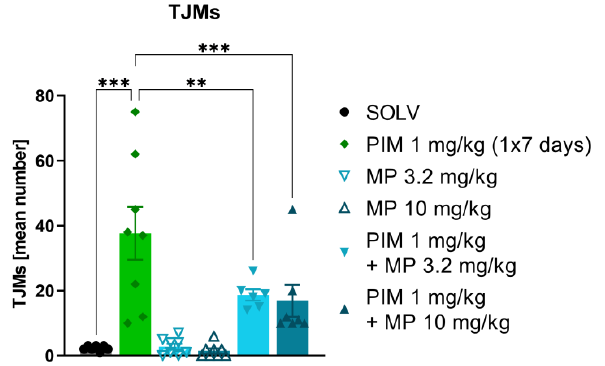
Figure 3. Reversal of the pimozide-induced tremulous jaw movements (TJMs) by MP-III-024 (3.2, 10 mg/kg). The data are shown as the mean (± SEM) number of tremulous jaw movements (TJMs) per 10 min observation period. The number of animals: SOLV, n = 7; PIM 1 mg/kg, n = 8; MP 3.2 mg/kg, n = 8; MP 10 mg/kg, n = 8, PIM 1 mg/kg + MP 3.2 mg/kg, n = 6; PIM 1 mg/kg + MP 10 mg/kg, n = 7. Statistics: Factorial ANOVA (PIM effect: F[1,38] = 41.736, p = 0.001; MP effect: F[2,38] = 3.919, p = 0.028) + LSD post-hoc test (** p ≤ 0.01, *** p ≤